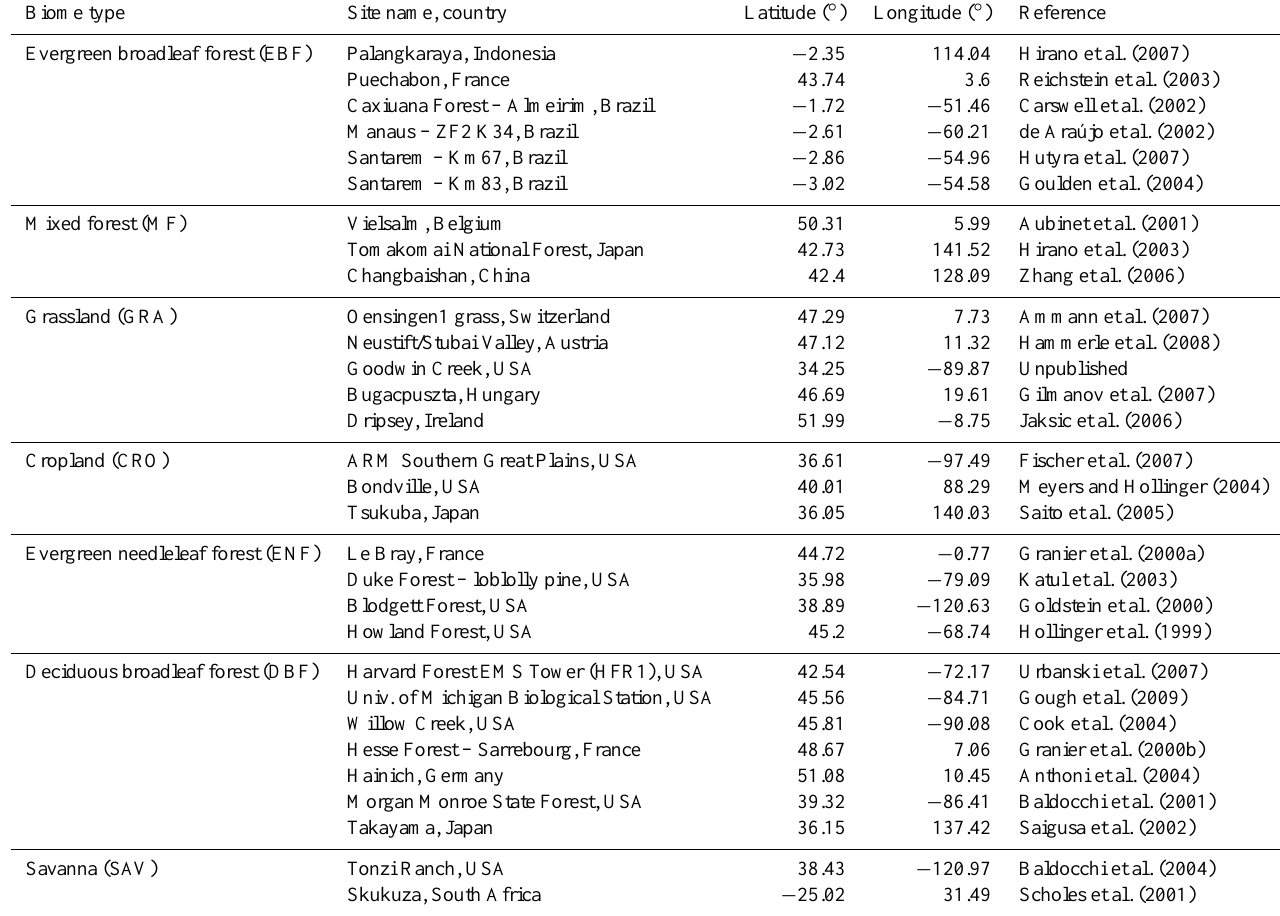
Table 1. Eddy covariance sites used for the evaluation of the satellite-derived R N and (cid:56) . Biome